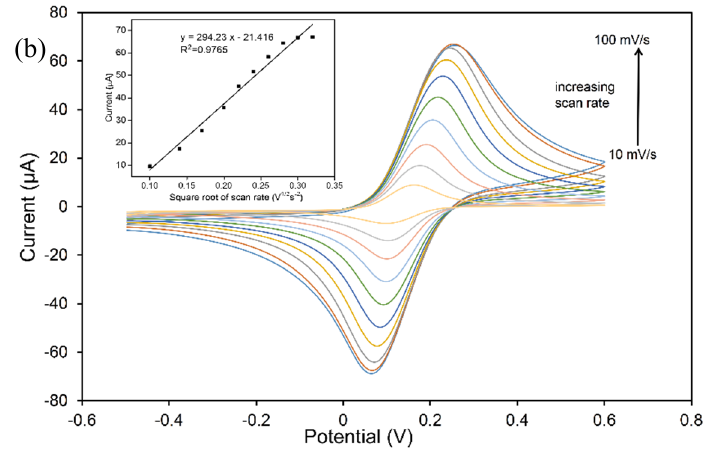
Figure 5. CV responses at different scan rates for the ( a ) bare SPCE and ( b ) SiNPs/SPCE. The insets show the corresponding linear calibration plot of the peak current against square root of the scan rate.